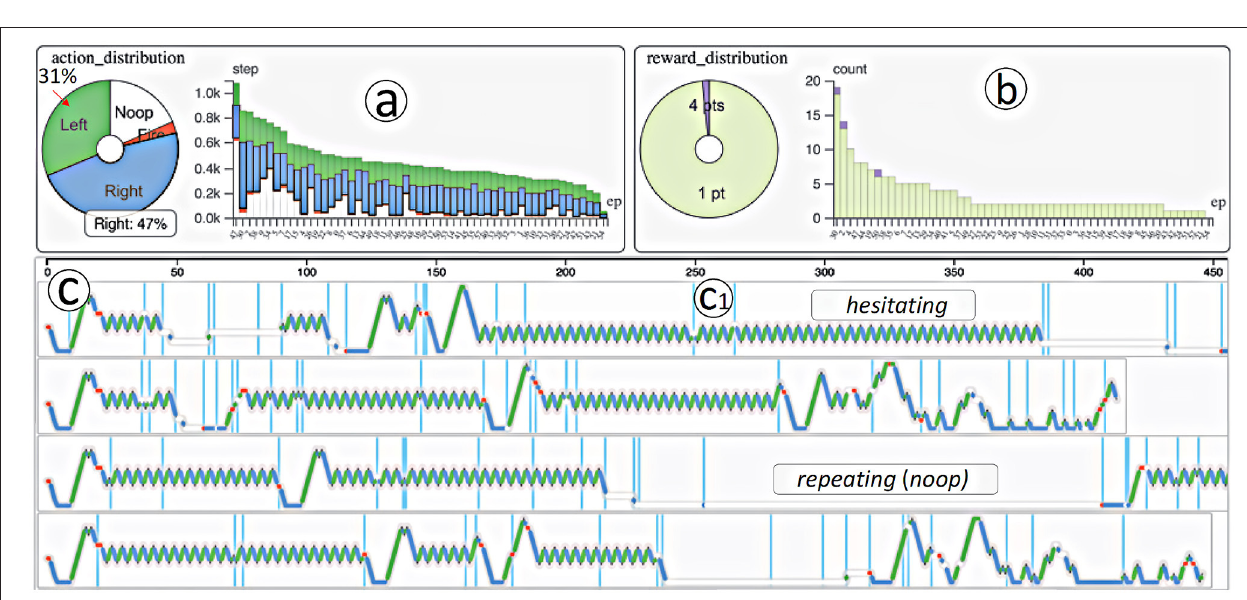
FIGURE 5 | Categorization of papers by scope. Note that some papers were multi-faceted and covered multiple categories.